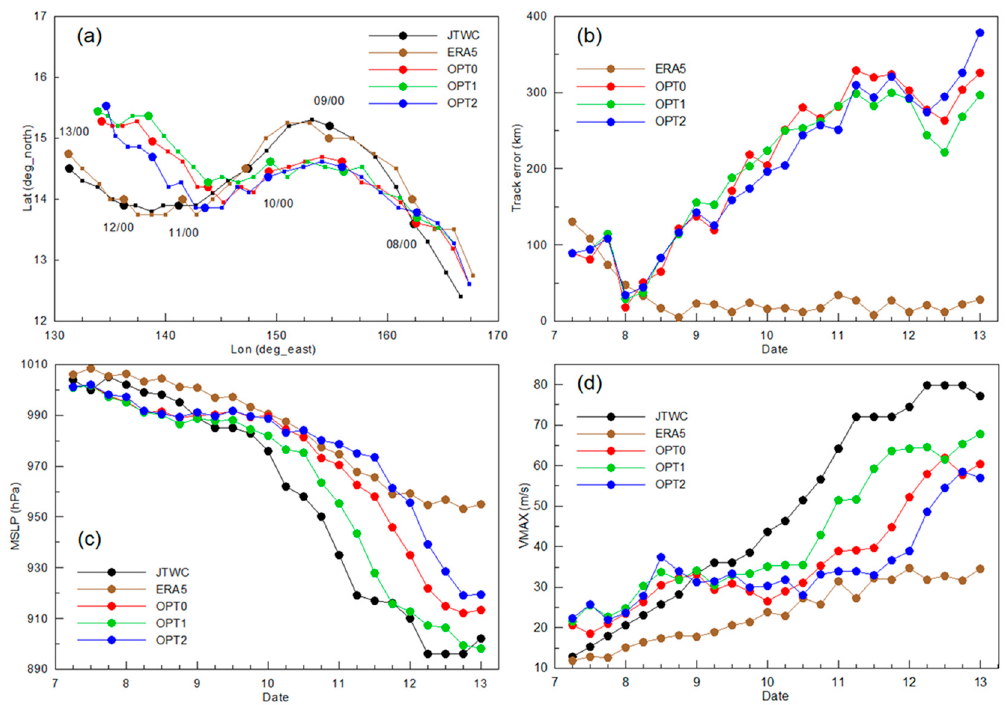
Figure 3. ( a ) TC track, ( b ) time series of track error (unit: km), ( c ) minimum central sea level pressure (MSLP) (unit: hPa), and ( d ) maximum sustained wind speed (VMAX) (unit: m s − 1 ) from the JTWC best track data; ERA5 reanalysis data and the numerical simulations from 0600 UTC 7 to 0000 UTC 13 September 2018.